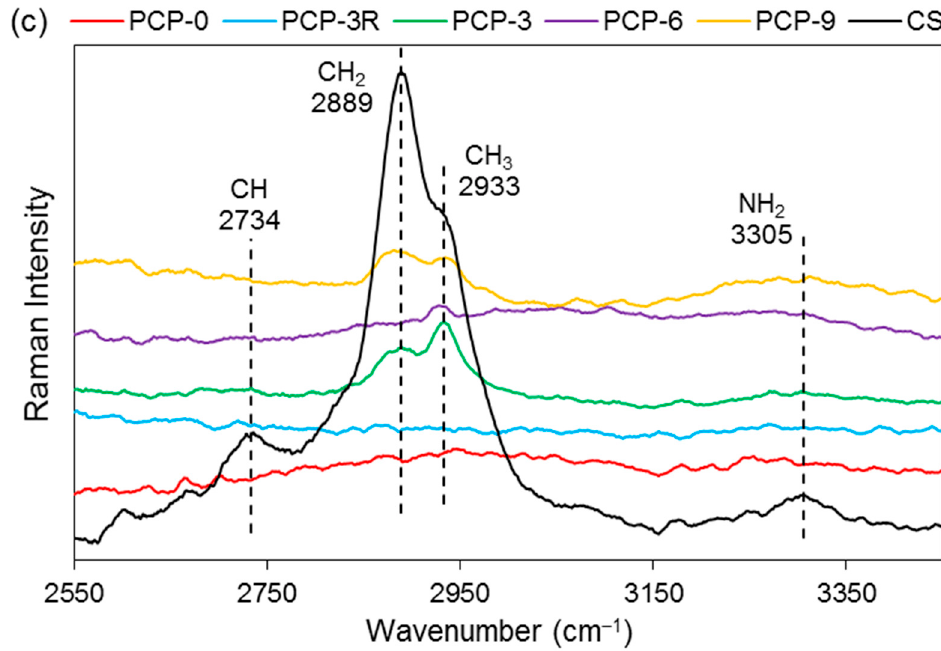
Figure 7. Raman spectra of the coated/uncoated fibres and the pure CS powder at the band range of ( a ) 250–1300 cm − 1 , ( b ) 1300–1750 cm − 1 and ( c ) 2550–3400 cm − 1 .